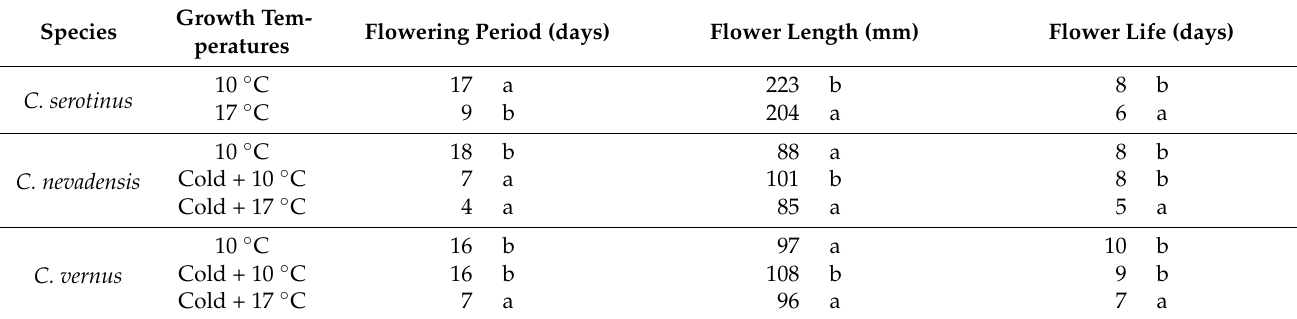
Figure 6. Cumulated values of number of flowers per corm in the autumn C. serotinus and the spring-flowering C. nevadensis and C. vernus exposed to various temperature regimes. C. serotinus was grown at a constant 10 ◦ C or 17 ◦ C. Corms of C. nevadensis and C. vernus were exposed to 9 cold weeks prior to growth at 10 or 17 ◦ C. In addition, they were grown at a constant 10 ◦ C. Each treatment contained two to four replicates of 10–30 corms (see Table 1 for a more detailed overview of treatments). Table 4. Effect of temperature on the flower size, flowering period and the average life of the flower of the crocus species. The corms were stored at 23 ◦ C from their harvest at the end of June, until planting in mid-September. Flower length is measured during anthesis. Flower period is recorded as the length of time a plant population is flowering. Flower life is measured as the days from when one individual flower emerges until it begins to wilt. Fifteen plants per treatment were